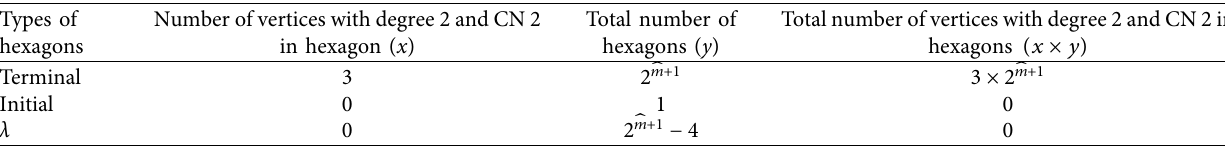
Table 3: Total number of vertices with degree 2 and CN 2 in ζ .